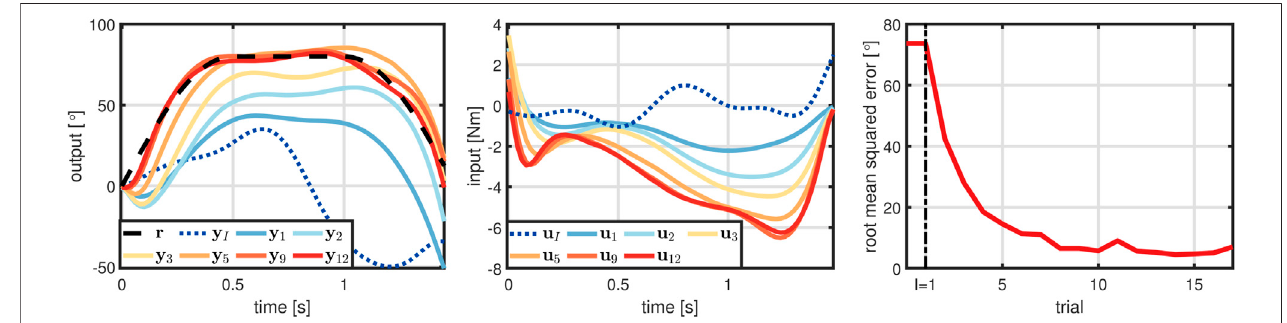
FIGURE11| ExperimentalresultsoftheTWIPRlearningtodivebeneathanobstacle.StartingfromaninitialRMSEofroughly75 ° ,thetrackingerrorrapidlydeclines over the following trials and suf fi ciently precise tracking for diving beneath the obstacle is achieved on the seventh trial.